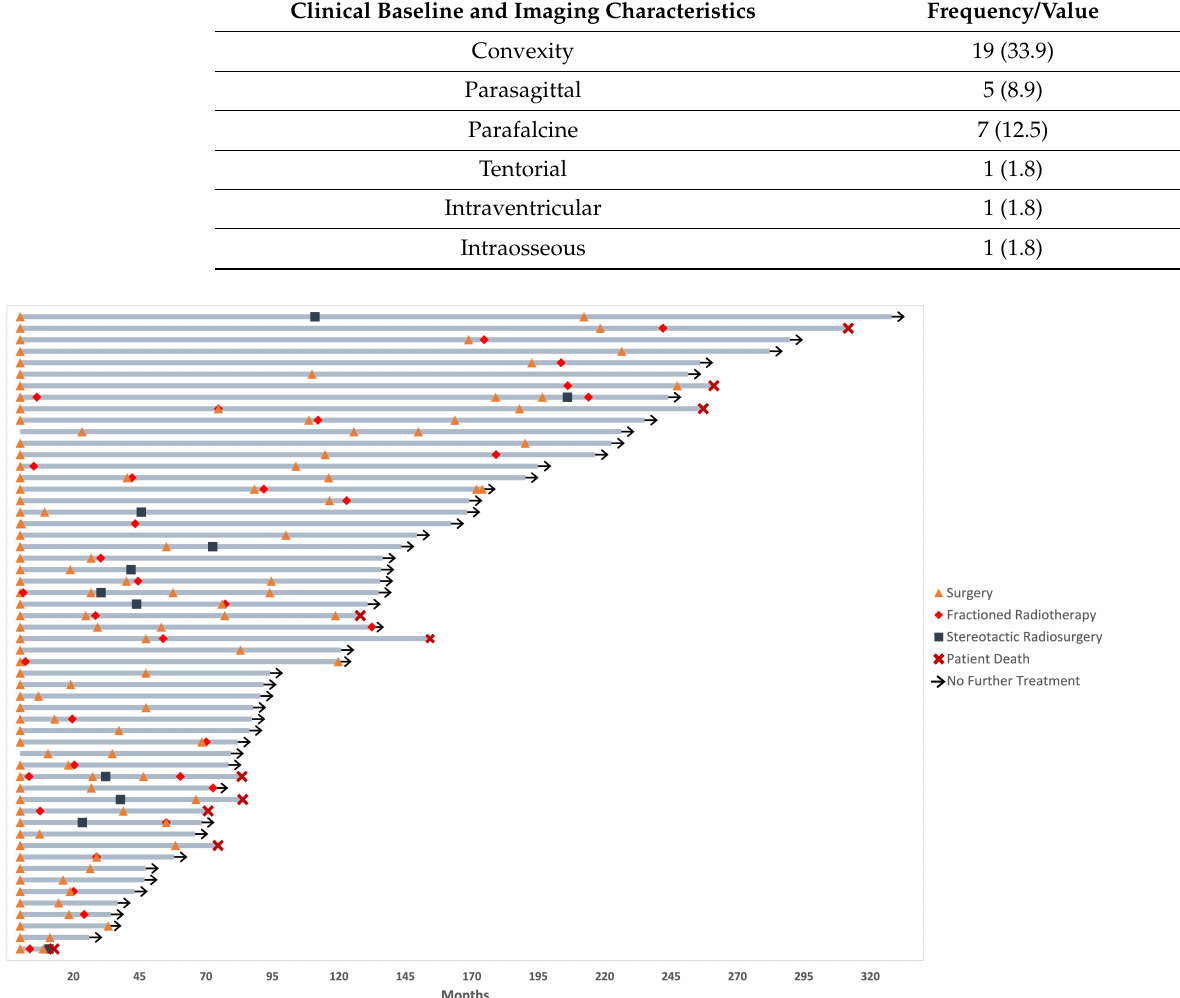
Figure 1. Swimmer Plot showing the treatment pathways for each patient in the cohort. The key is provided to the right. Individuals with no surgery at the beginning of treatment strategy were incidental, with primary and subsequent operations occurring at a later point during